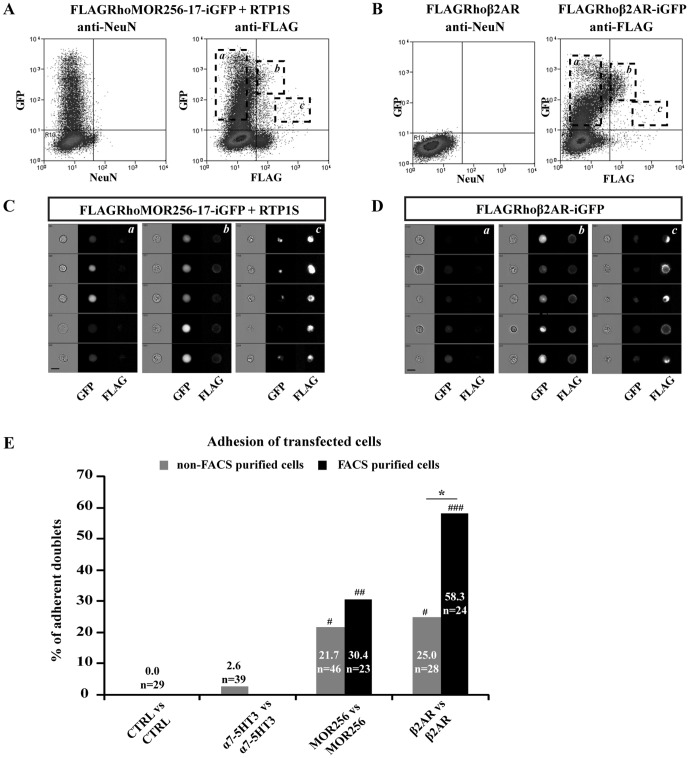
FACS purification of transfected cells increases the ratio of adherent cells.(A–B) FACS profiles of FLAGRhoMOR256-17-iresGFP+RTP1S transfected cells (A) and FLAGRhoβ2AR or FLAGRhoβ2AR-iresGFP transfected cells (B). Non-specific fluorescence was gated using isotypic control antibody (anti-NeuN) on FLAGRhoMOR256-17-iresGFP+RTP1S transfected cells and on FLAGRhoβ2AR transfected cells. FACS analysis revealed a major population of GFP+ FLAG− cells (subpopulation a), as well as a smaller population of FLAG+ GFP+ double stained cells (subpopulations b and c). (C–D) ImageStream analysis of transfected cell subpopulations delineated as a, b and c in A and B. The subpopulations b were selected for purification and subsequent adhesion test, as these cells displayed a healthy morphology, cytoplasmic GFP staining and surface staining for FLAG. Subpopulations a and c were excluded from our analyses since these cells displayed no surface FLAG staining (a) or were dying cells (c). Scale bar = 15 µm. (E) Adhesion of FACS purified MOR256-17 or β2AR-expressing cells compared to CTRL or α7-5HT3 expressing cells. FACS purified cell doublets display significantly higher adhesion ratio when compared to CTRL or α7-5HT3 doublets. FACS purification significantly increases the adhesion ratio of β2AR-expressing cell doublets. * p<0.05. # p<0.05, ## p<0.01, ### p<0.001 compared to CTRL and to α7-5HT3.